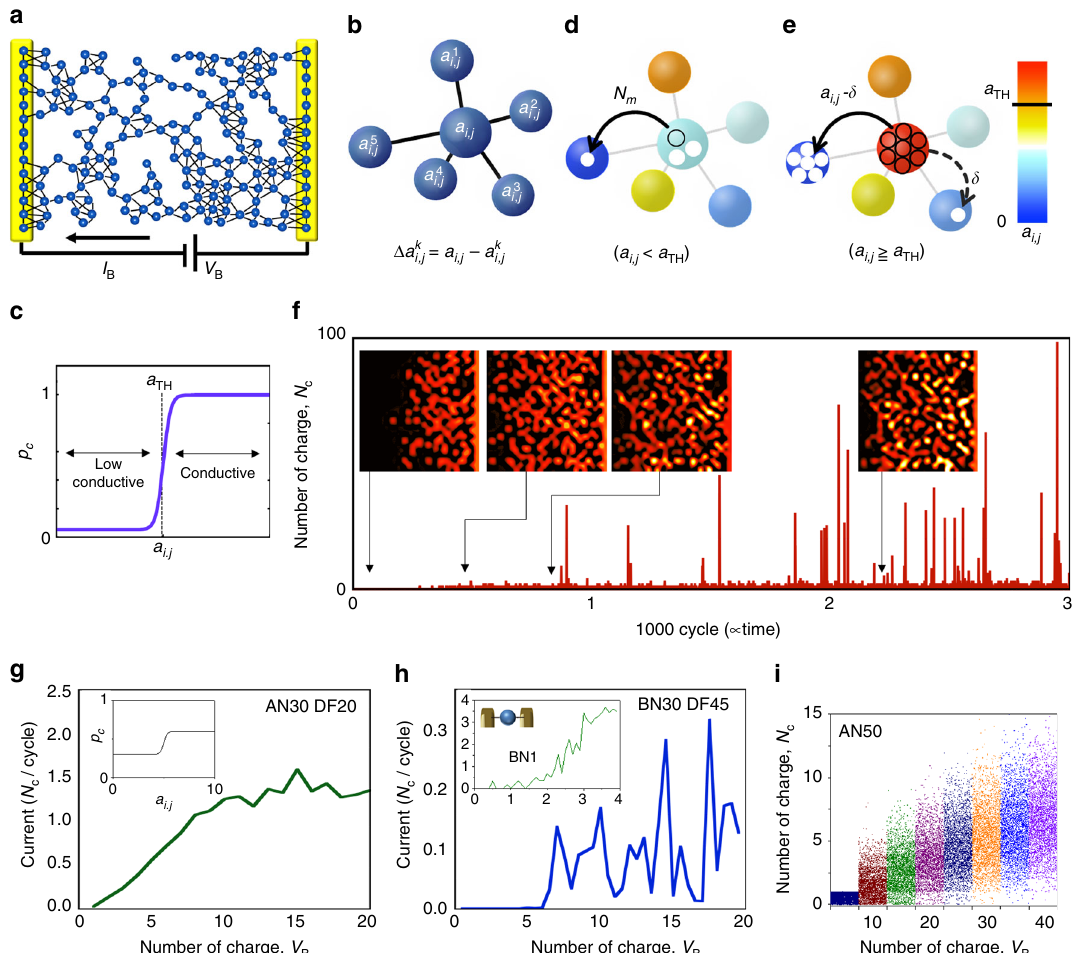
Fig. 4 2D CA model of the SWNT/POM network. a CA model on a 2D grid consisting of POM cells (blue spheres) connected with black SWNT wires and the source (S, right) and drain (D, left) electrodes. The network is on 20×14 intersection points on a 2D regular grid, and 45% of which are randomly chosen as ‘ detects ’ ( D f = 45%), while the rest are the POM cells. b Notation of cell interaction for the state transition. The transition direction at time t is selected to yield the largest gradient for state Δ a k i ; j among all k neighbours. c State transition probability showing P B c . d , e Schematics for two types of state transition rules applicable ( d ) when a i,j < a TH and ( e ) for discharging when a i,j > a TH . f Calculated impulse generation results for 3000 cycles in a 30×30 array with P A c , V B = 6, a TH = 5 and D f = 45%. Hereafter, AN30 denotes the results for a 30×30 array with P A c and DF45 denotes D f = 45%. The inserted images are snapshots of the numbers of states in each cell at a given time. g , h Calculated I – V characteristics for AN30DF20 and BN30DF45, respectively, with a H = 5. g The inset shows P A c . The de fi nition of current is the number of charges transferred to the drain electrode N c averaged over 5000 cycles. h The inset shows I – V for a single cell with P B c , directly connected with the electrodes. i Noise generation in the base current, plotted over 5000 cycles with stepwise increment of V B for AN50 with a TH =